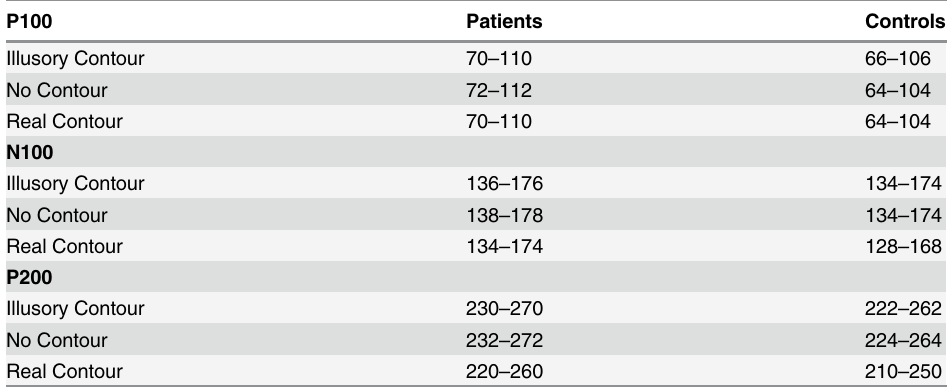
Table 2. Time-windows (in ms) of analysis for schizophrenia patients and healthy controls for illusory, no contour, and real fi